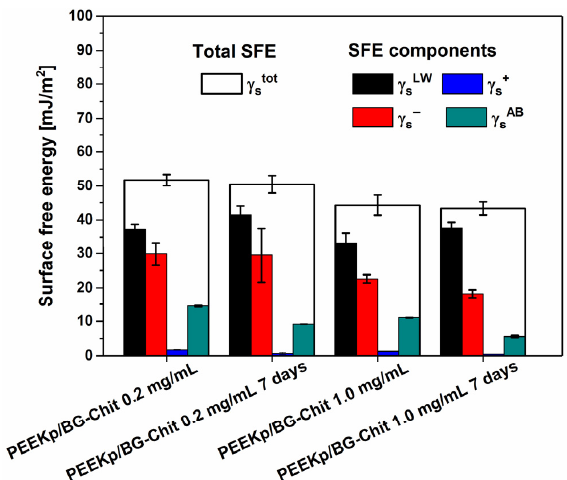
Figure 8. Surface free energy and its components, determined for modified PEEK surfaces, fresh and after 7 days. The error bars denote the maximum and minimum values of surface free energy and its components calculated for 2 samples of each studied surface from the 10–15 contact angle values of each liquid (their averages).